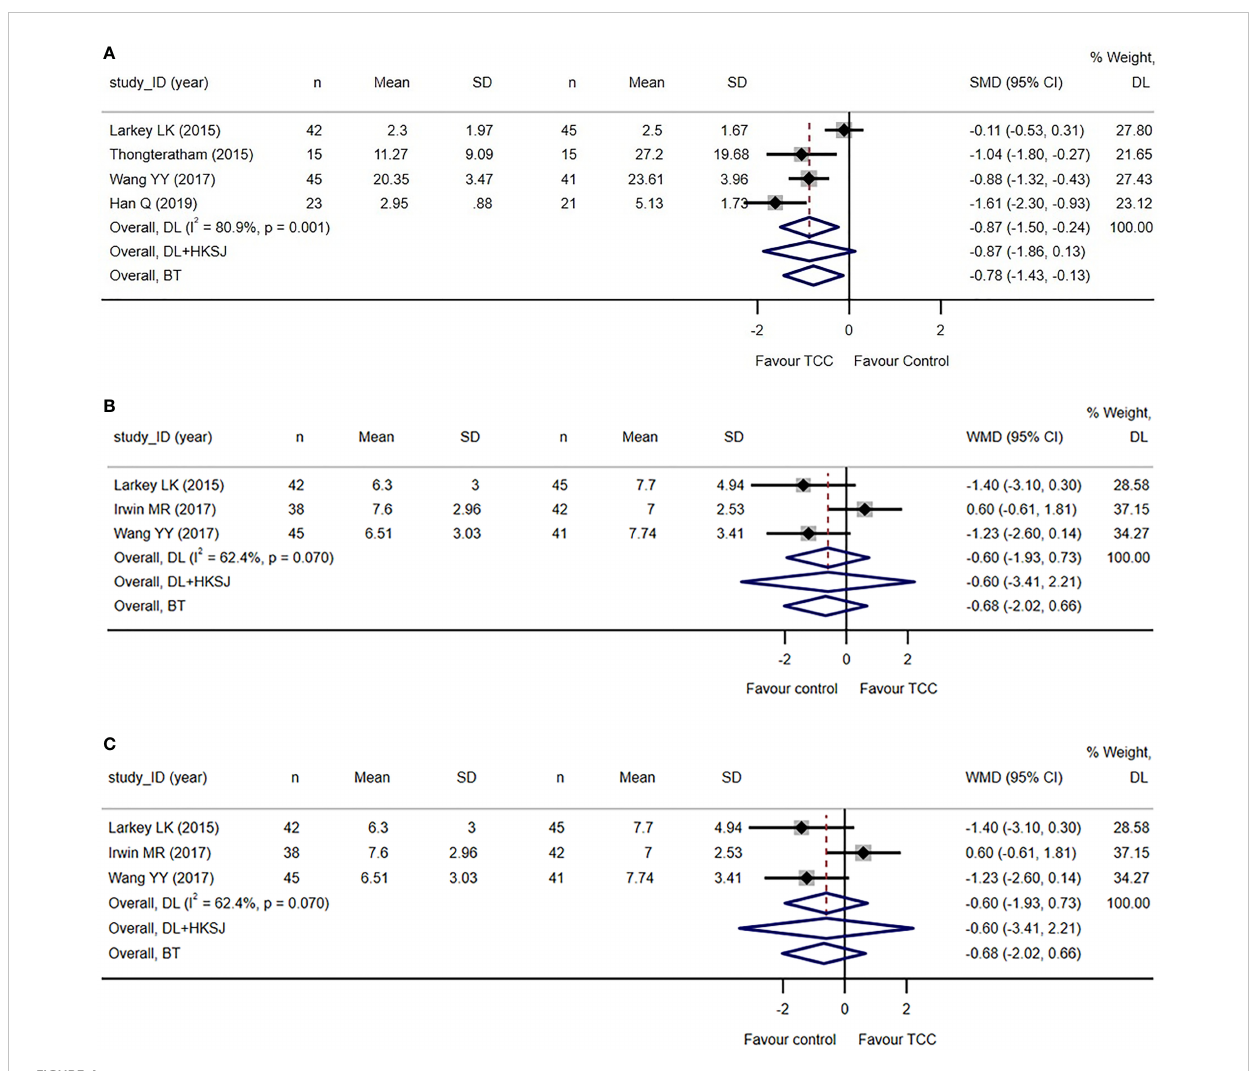
FIGURE 4 Secondary and post-hoc outcomes of the systematic review of Tai Chi Chuan training on the QoL and psychological well-being in female patients with breast cancer. (A) TCC-based exercises are superior to other interventions on fatigue when tau 2 was calculated by DL estimator in random effect model. Sensitivity analysis using DL + HKSJ as tau 2 estimator shows no difference between the two groups. (B) No difference between TCC- based interventions and other interventions on sleep quality. (C) TCC-based exercises are superior to the controls on shoulder function in breast cancer patients. The weights of trials were provided by random effect model applying DL tau 2 estimator. BT, Biggerstaff – Tweedie approximate Gamma model; DL, DerSimonian – Laird estimator of tau2; DL+HKSJ, Hartung – Knapp – Sidik – Jonkman (HKSJ) variance correction to DerSimonian – Laird estimator of tau 2 ; SD, standard deviation; SMD, standardized mean difference; TCC, Tai Chi Chuan. The study ID consists of the fi rst author ’ s surname, the capital initials of the fi rst author ’ s fi rst name, and the year the fi rst report of the RCTs was published or submitted as